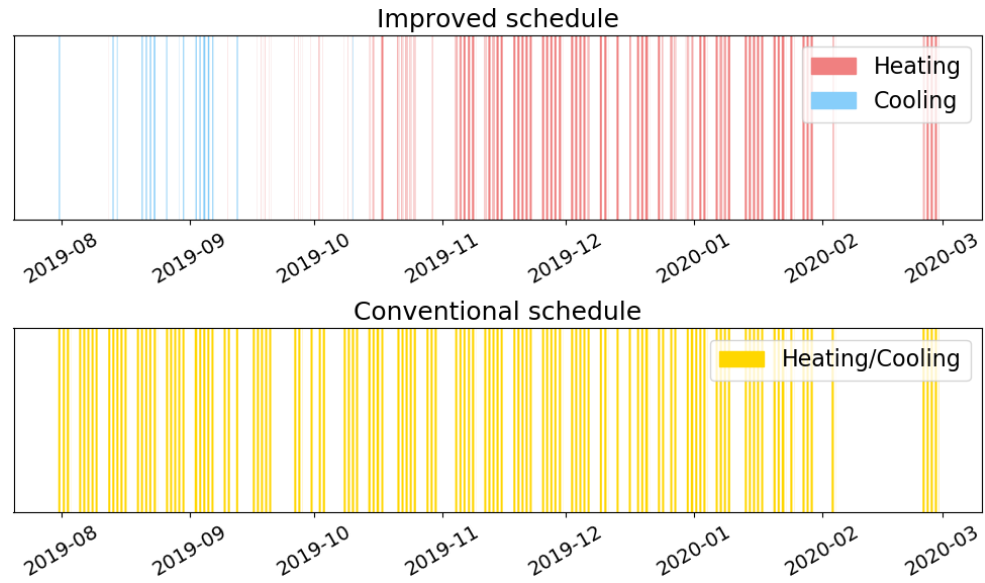
Figure 8. Comparison between conventional and improved ON/OFF schedules of the HVAC